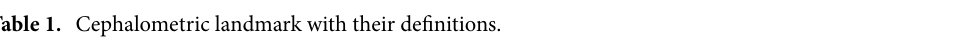
Table 1. Cephalometric landmark with their